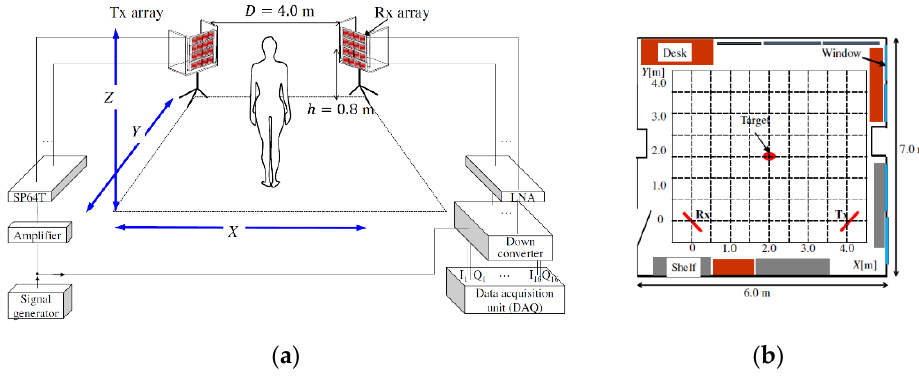
Figure 9. ( a ) Measurement setup and ( b ) experimental environment [49].